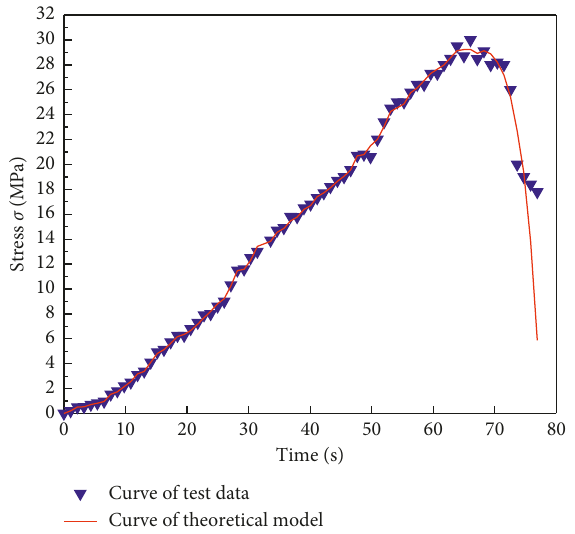
Figure 12: Comparison between test and model about relationship of σ , t at strain gauge 6.